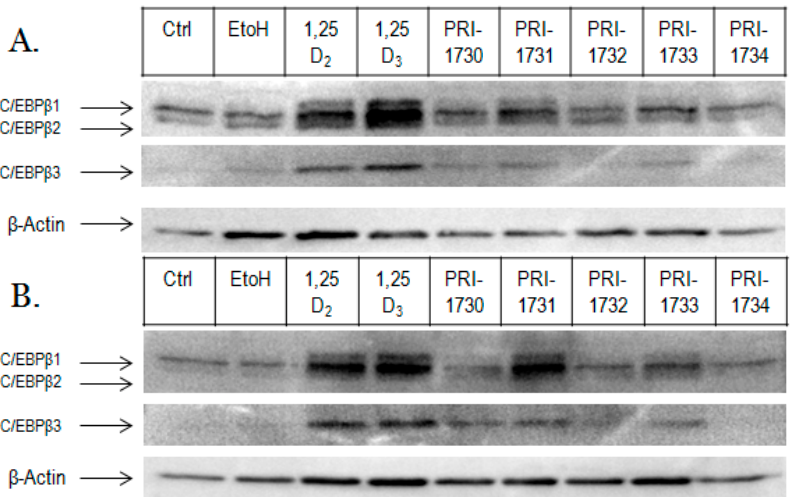
Figure 5. C/EBP β isoforms in HL60 cells treated with 1,25D 2 , 1,25D 3 and analogues at 10 nM ( A ) and 100 nM ( B ) concentrations. HL60 cells were treated for 72 h with 1,25D 2 , 1,25D 3 and analogues. The nuclear fraction was separated by electrophoresis and transferred onto PVDF membrane and probed with antibodies against C/EBP β , and β -actin as fractionation/loading controls. In addition to the three C/EBP β isoforms, unidentified bands, possibly cleavage products of C/EBP β , are present.